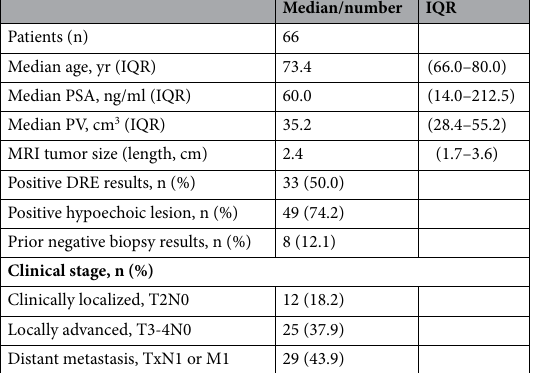
Table 1. Patient characteristics. IQR, interquartile range; PSA, prostate-specific antigen; PV, prostate volume; MRI, magnetic resonance imaging; DRE, digital rectal examination.